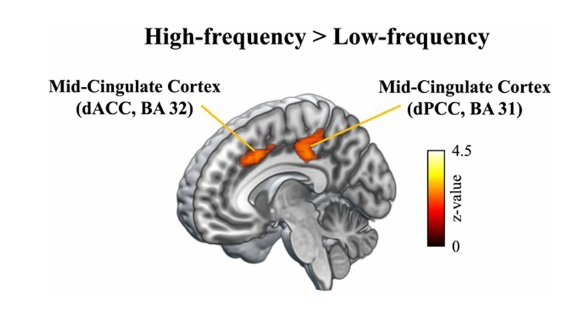
FIGURE 5 Contrast of high-frequency vs. low-frequency idiomatic